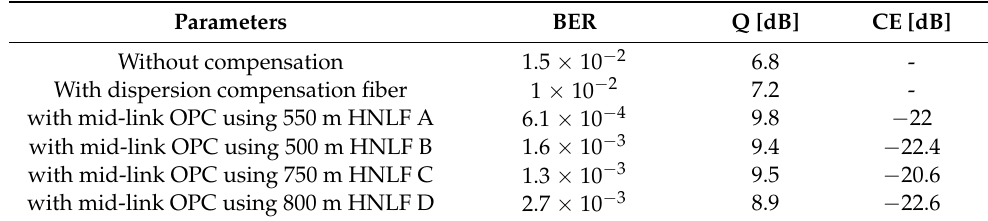
Figure 6. A comparison of Q-factor gains versus optical signal-to-noise ratio (OSNR) after 800 km transmission. Table 3. A comparison of OPC performance at OSNR 34 dB.